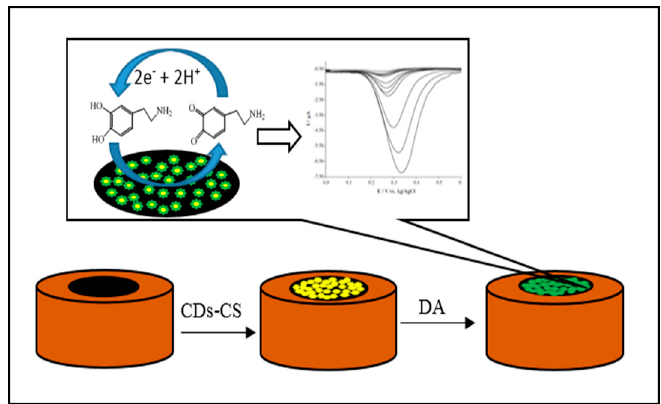
Figure 13. Electrochemical detection of DA with composite (Reproduced from [80], copyright RSC, Figure13. ElectrochemicaldetectionofDAwithcomposite(Reproducedfrom[80], 2013).